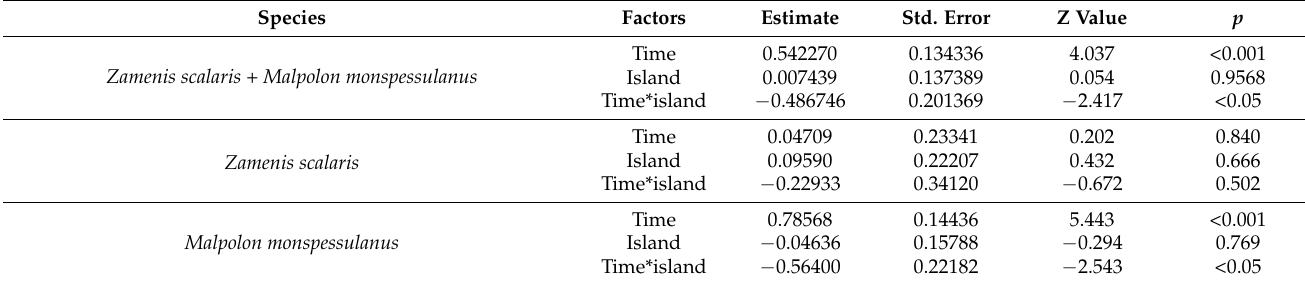
Table 2. Results of the generalized linear models’ analysis testing the influence of time (before 2016 versus after 2016 = BA), site (islands, CI), and their interaction (*, BACI) on snake